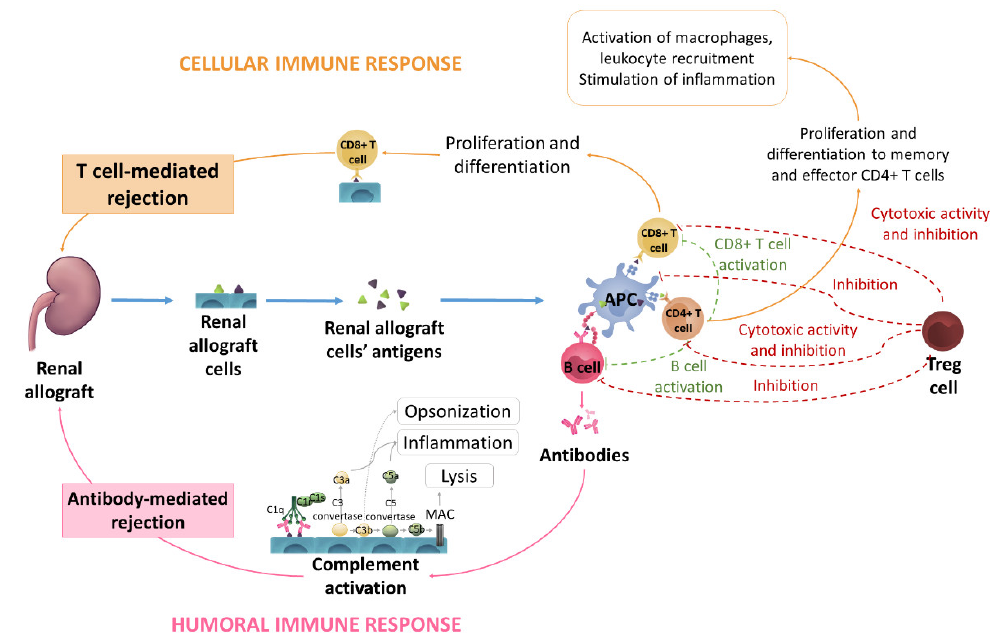
Figure 5. Schematic representation of different allograft rejection mechanisms. Renal allograft cells’ antigens are processed by APC cells that present the antigens to T and B cells. Activated B cells produce antibodies, which activate the complement system, leading to an antibody-mediated rejection via opsonization, inflammation and lysis processes. Activated CD4+ T cells start their proliferation and differentiation to memory and effector CD4+ T cells. These effector CD4+ T cells activate macrophages and leukocyte recruitment and stimulate inflammation. Moreover, CD4+ cells activate B and CD8+ T cells. CD8+ T cells can also be triggered by APC cells; once CD8+ T cells are activated, they proliferate and differentiate, leading to allograft T-cell-mediated rejection. Treg cells participate in this mechanism by inhibiting B cells and APC cell activity and releasing granzymes and perforins that destroy T cells.